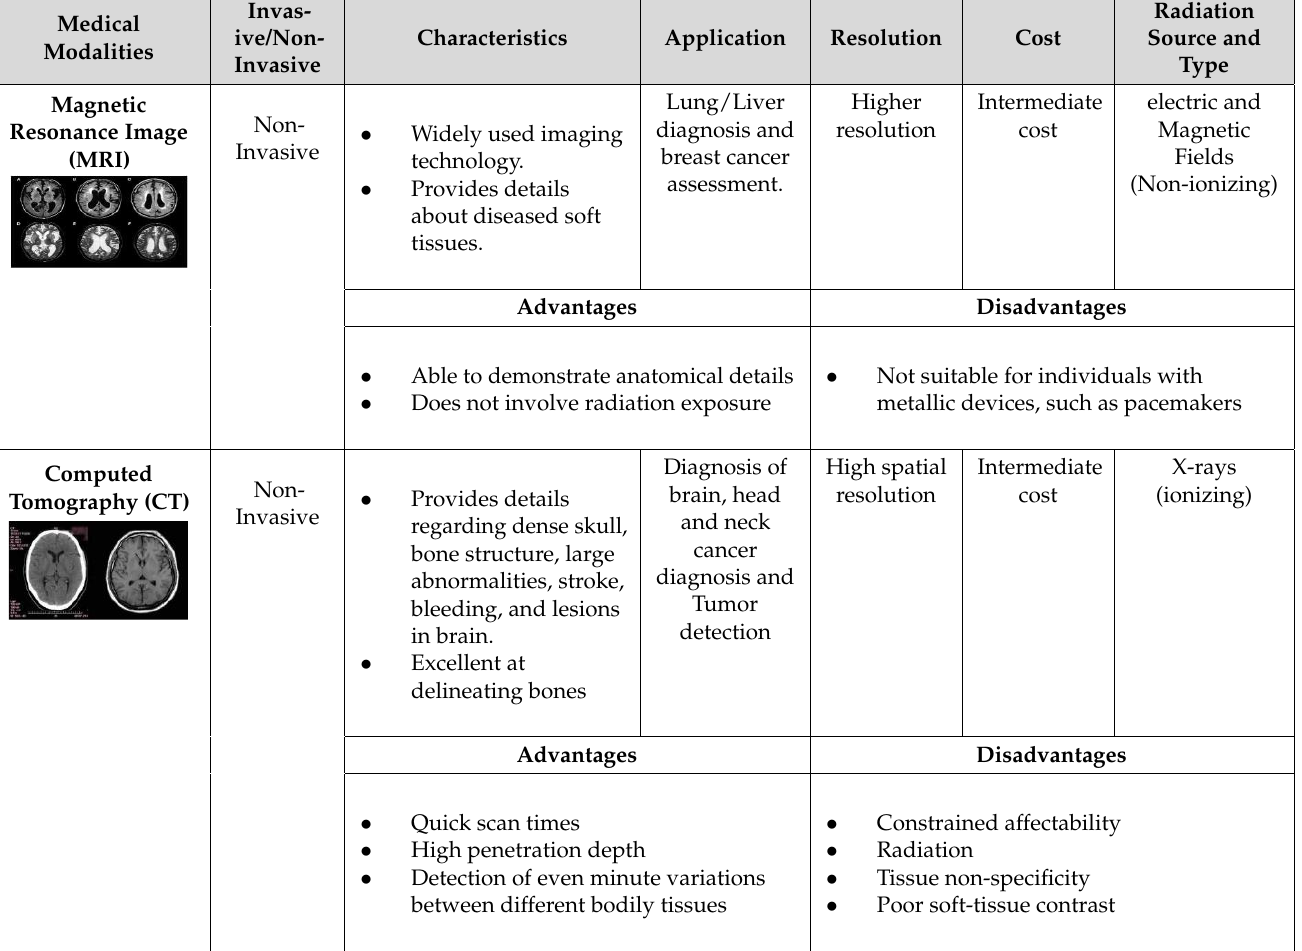
Table 1. A brief overview of various medical imaging modalities